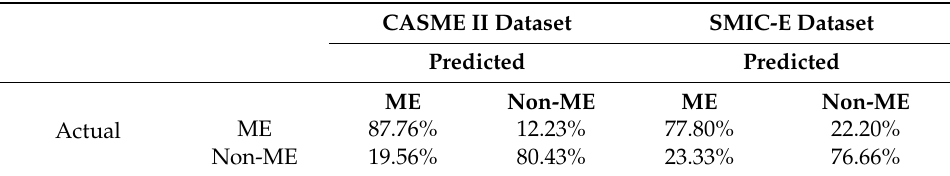
Table 1. ME detection confusion matrices on the CASME II and SMIC-E